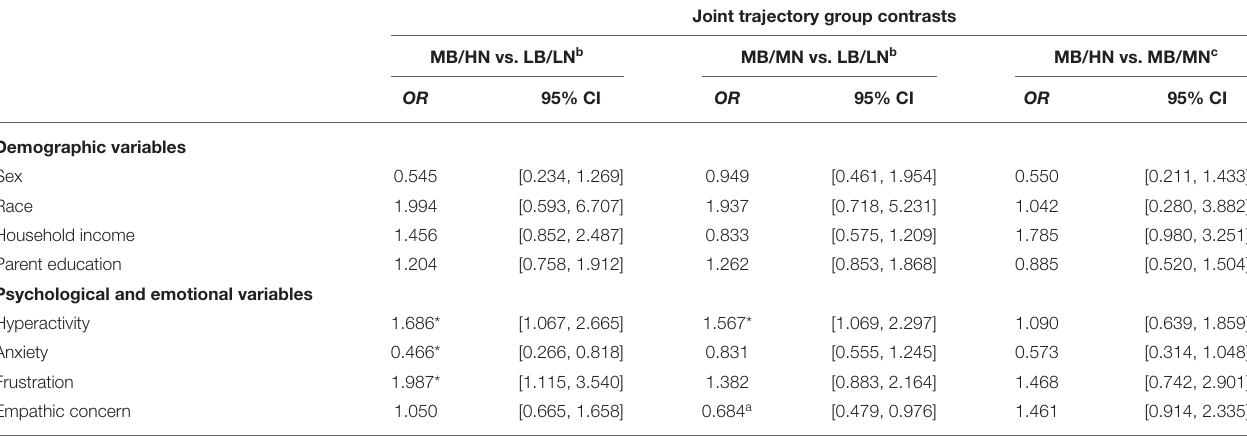
TABLE 5 | Multinomial logistic regression of childhood variables predicting joint trajectory groups of bullying perpetration and narcissistic personality